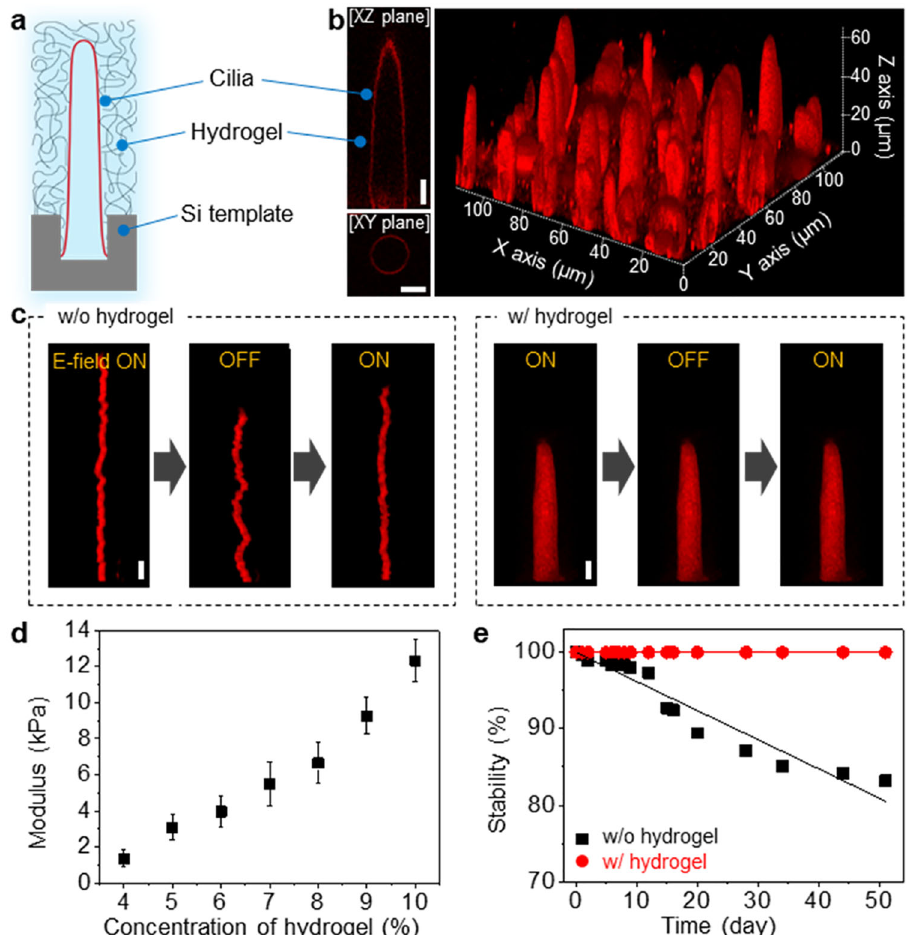
Fig. 4 Structural and mechanical properties of a cilia-like 3DBCPM supported with a hydrogel. a Schematic illustration of a cilia-like 3DBCPM with a hydrogel as a support. b Confocal fl uorescence microscopy images of a hydrogel-supported 3DBCPM array. Scale bar: 5 μ m. c Time-sequential images of cilia-like 3DBCPMs with and without hydrogel support under a mild fl ow of aqueous solution. Scale bar: 5 μ m. d Mechanical modulus of 3DBCPMs with different hydrogel concentrations. Data are presented as means ± standard deviation ( n = 4 independent samples). e Mechanical stability of 3DBCPMs with and without hydrogel support in aqueous